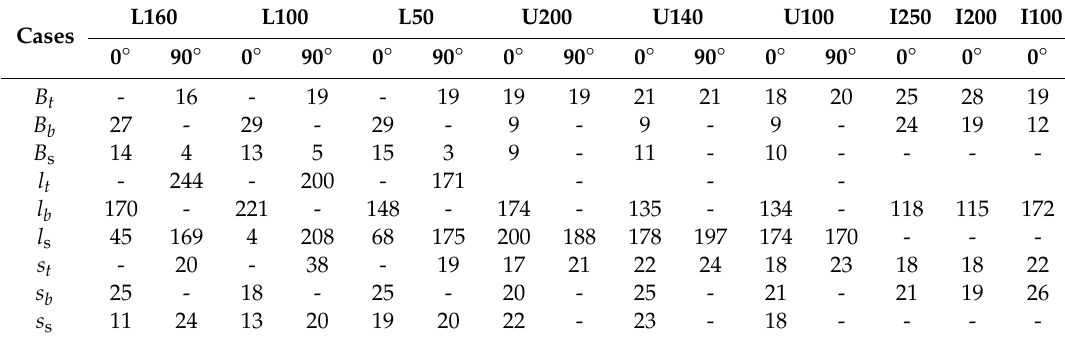
Table 2. Ice mean size of section steel for N = 80 (unit: mm).